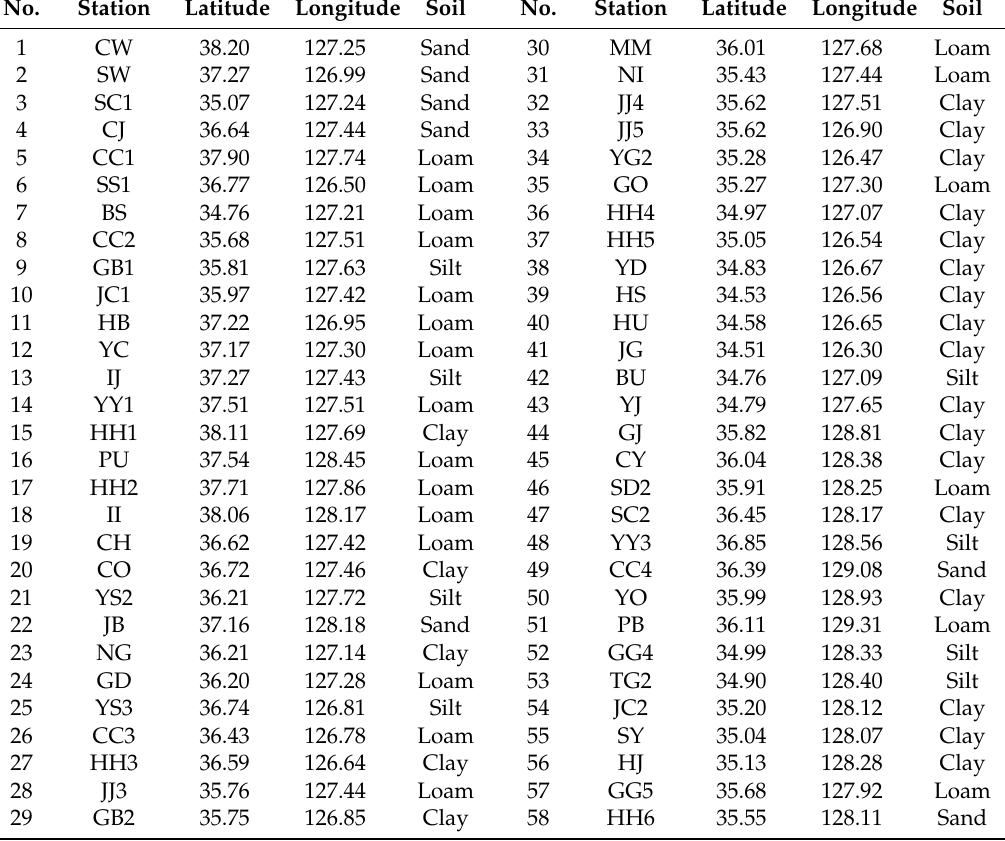
Table 2. Agrometeorological observation network of the Korea Meteorological Administration and the other observation points with soil